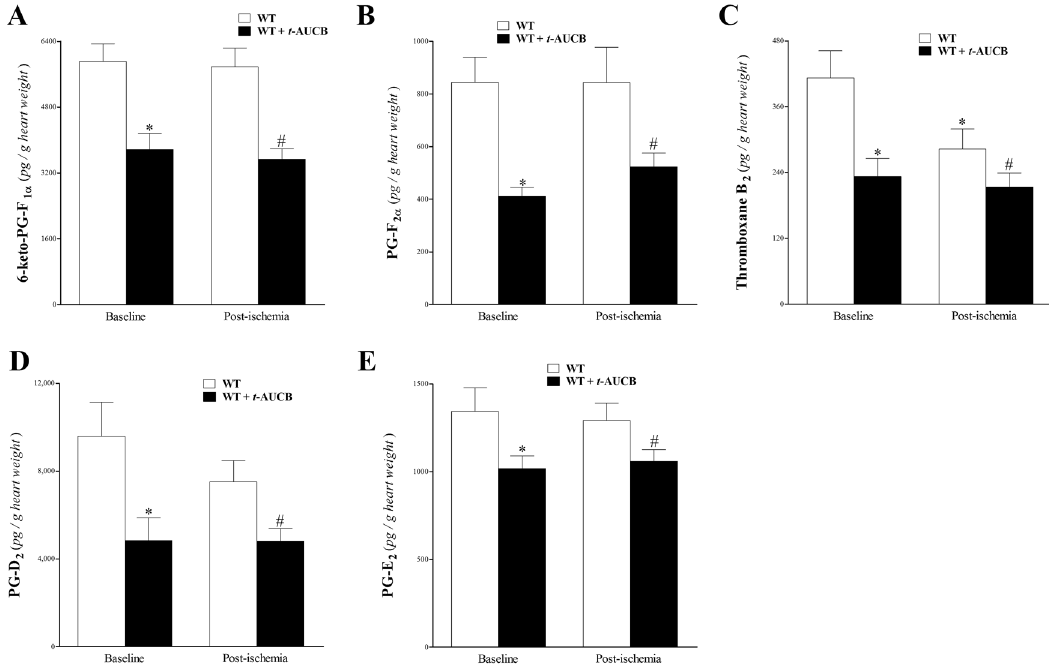
Fig 7. LC – MS/MS analysis of 6-keto-PG-F 1 α , PG-F 2 α , thromboxane B 2 , PG-D 2 , and PG-E 2 in WT and t- AUCB- treated WT mouse heart perfusates at baseline (pre-ischemia) and post-ischemia. Infusion of t -AUCB decreased 6-keto-PG-F 1 α (A), PG-F 2 α , (B), thromboxane B 2 (C), PG-D 2 (D), and PG-E 2 (E), at baseline and post-ischemia (p < 0.05). Compared to baseline WT, post-ischemia WT levels were decreased for thromboxane B 2 , and PG-D 2 , but were significant (p < 0.05) only for thromboxane B 2 (C). * p < 0.05 versus baseline WT. # p < 0.05 versus post-ischemia WT. n = 8.